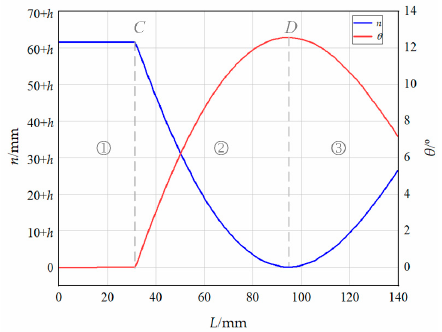
Figure 5. The relationship between L and θ and n. Note: C and D are the two points through which the constraint part moves from chassis to finger ends. 1 (cid:13) , 2 (cid:13) and 3 (cid:13) are three stages divided by the changes in n and θ .